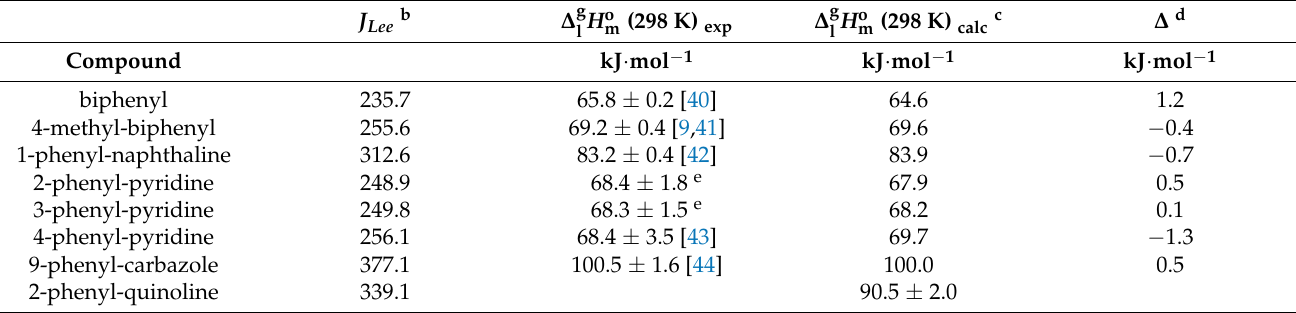
Table 7. Correlation of vaporization enthalpies, ∆ g ( J Lee ) on HP-5 column a